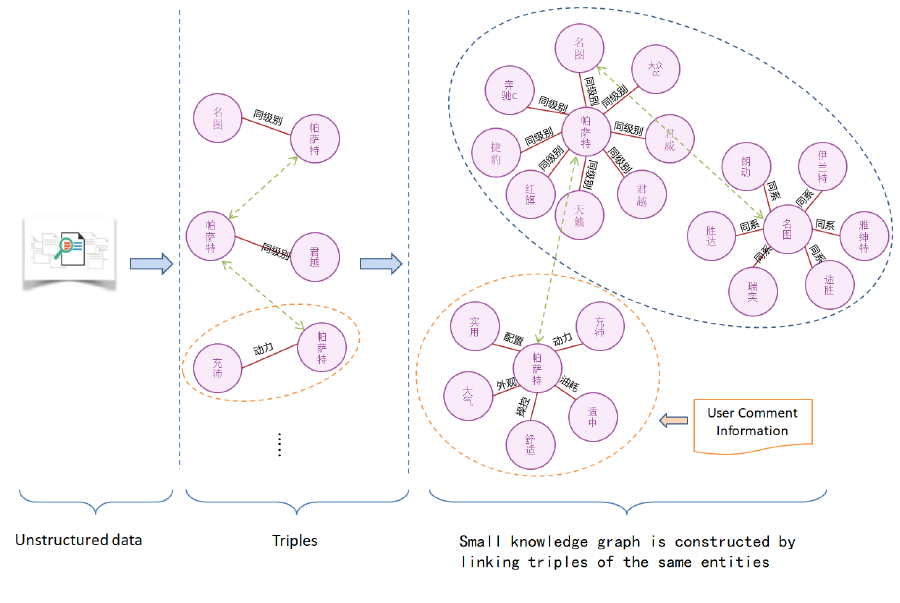
Figure 19. An example of the construction of knowledge graph.